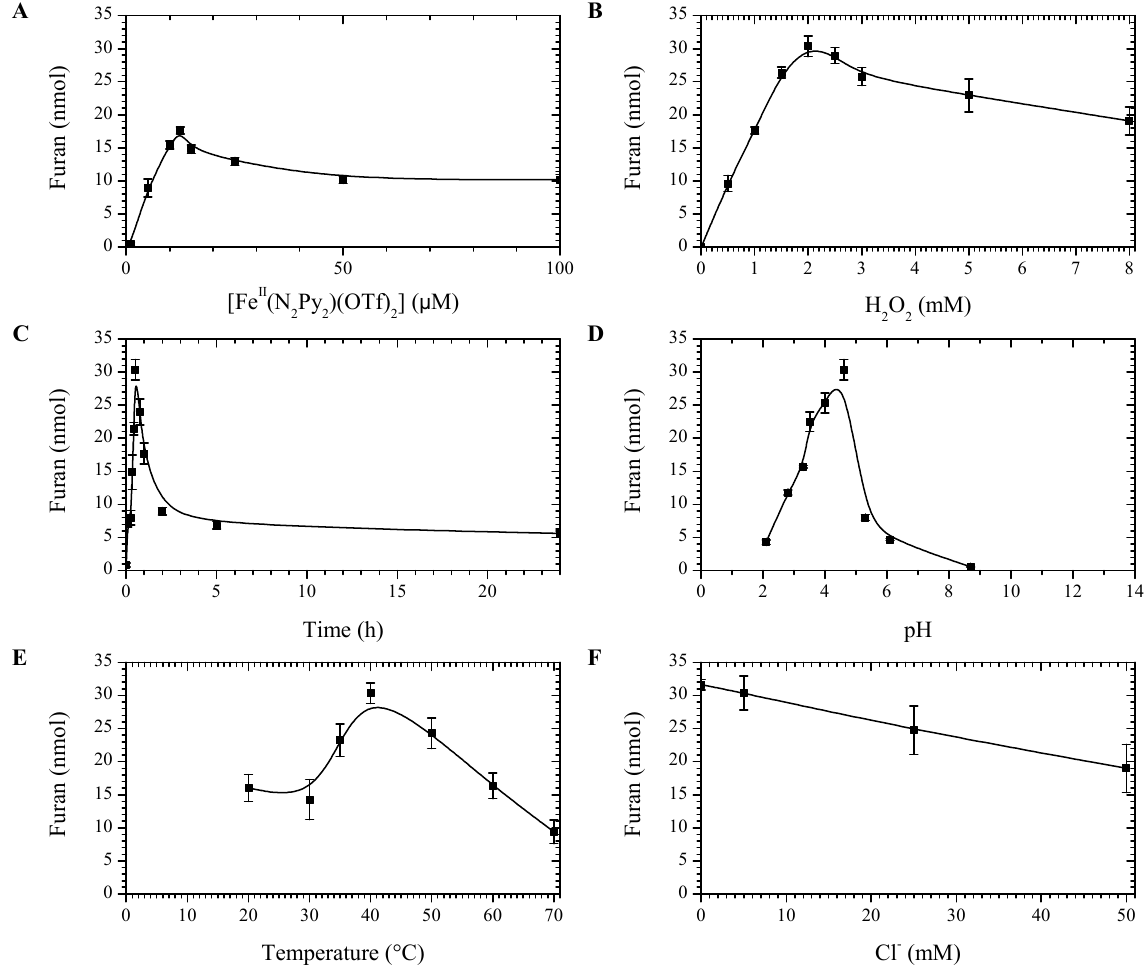
Figure 2. Effects of different parameters on the furan formation from a 10mL solution. (A) Variation of [Fe II ( N 2 Py 2 )( OTf ) 2 ]: reaction of 0.5mM catechol with 0–100µM [Fe II ( N 2 Py 2 )( OTf ) 2 ], 1mM H 2 O 2 , 5mM KCl at a pH of 4.6 and 40 ◦ C after 30min. (B) Variation of H 2 O 2 : reaction of 0.5mM catechol with 12.5µM [Fe II ( N 2 Py 2 )( OTf ) 2 ], 0–8mM H 2 O 2 , 5mM KCl at a pH of 4.6 and 40 ◦ C after 30min. (C) Time dependency: reaction of 0.5mM catechol with 12.5µM [Fe II ( N 2 Py 2 )( OTf ) 2 ], 2mM H 2 O 2 , 5mM KCl at a pH of 4.6 and 40 ◦ C after 0–24h. (D) Variation of pH: reaction of 0.5mM catechol with 12.5µM [Fe II ( N 2 Py 2 )( OTf ) 2 ], 2mM H 2 O 2 , 5mM KCl at a pH of 2.1–8.7 and 40 ◦ C after 30min. (E) Temperature dependency: reaction of 0.5mM catechol with 12.5µM [Fe II ( N 2 Py 2 )( OTf ) 2 ], 2mM H 2 O 2 , 5mM KCl at a pH of 4.6 and 20–70 ◦ C after 30min. (F) Variation of chloride: reaction of 0.5mM catechol with 12.5µM [Fe II ( N 2 Py 2 )( OTf ) 2 ], 2mM H 2 O 2 , 0–50mM KCl at a pH of 4.6 and 40 ◦ C after 30min. Data points represent mean values with error bars indicating standard deviations from triplicate